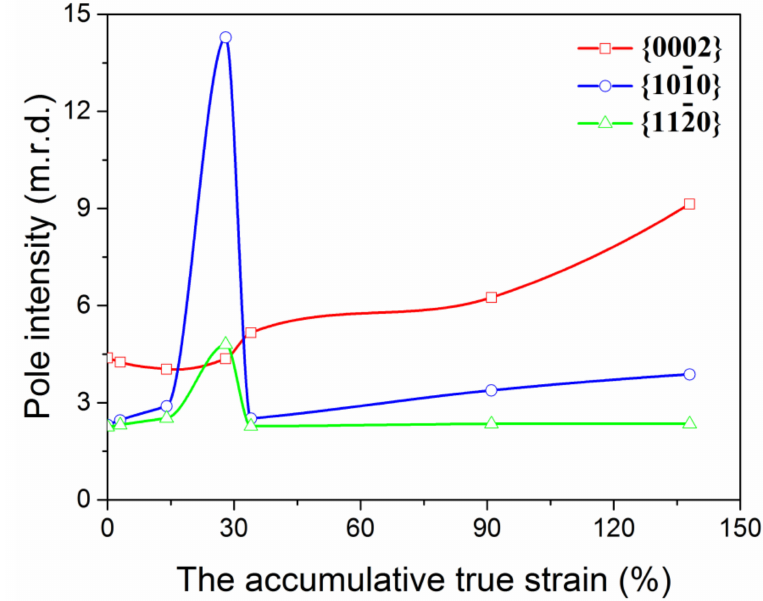
Figure 4. The maximum pole density of typical planes of as-drawn Mg wire with different